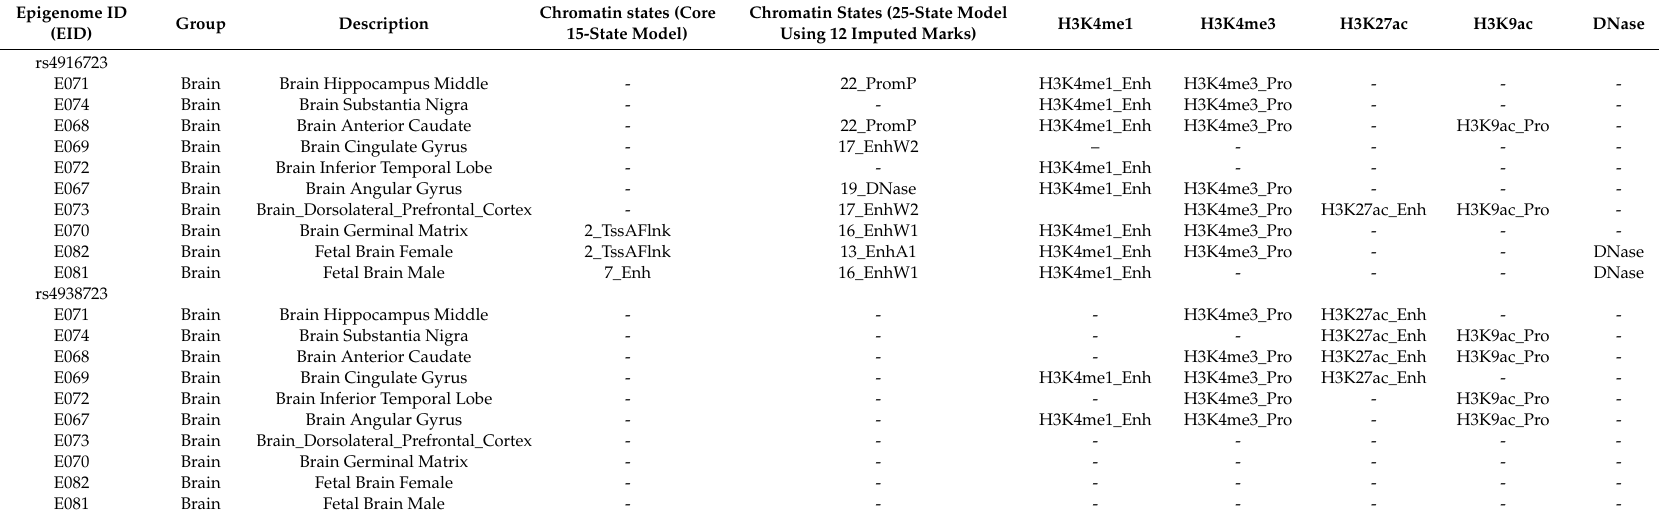
Table 4. Regulatory sites in brain regions available for the two evaluated SNPs (HaploReg v4.1).